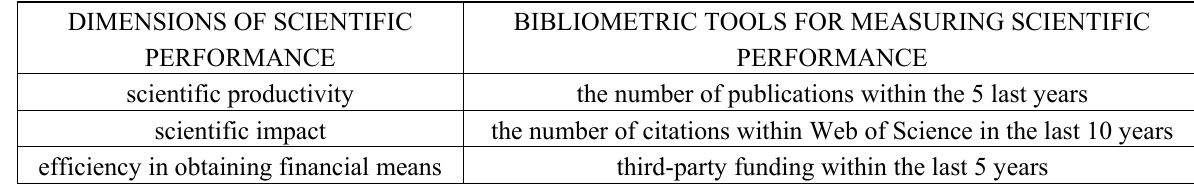
Table 1. Bibliometric tools for measuring scientific performances in external R&D